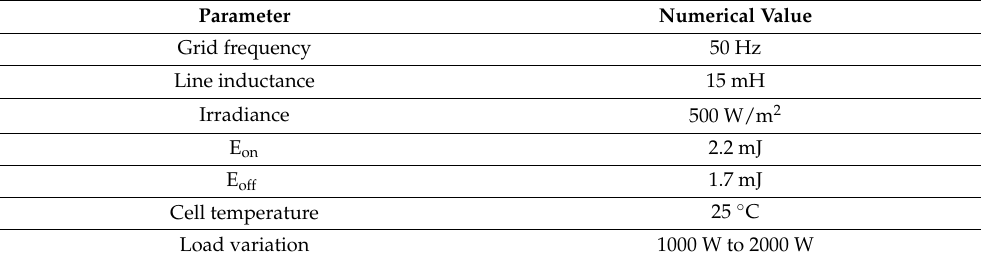
Table 3. System parameters.